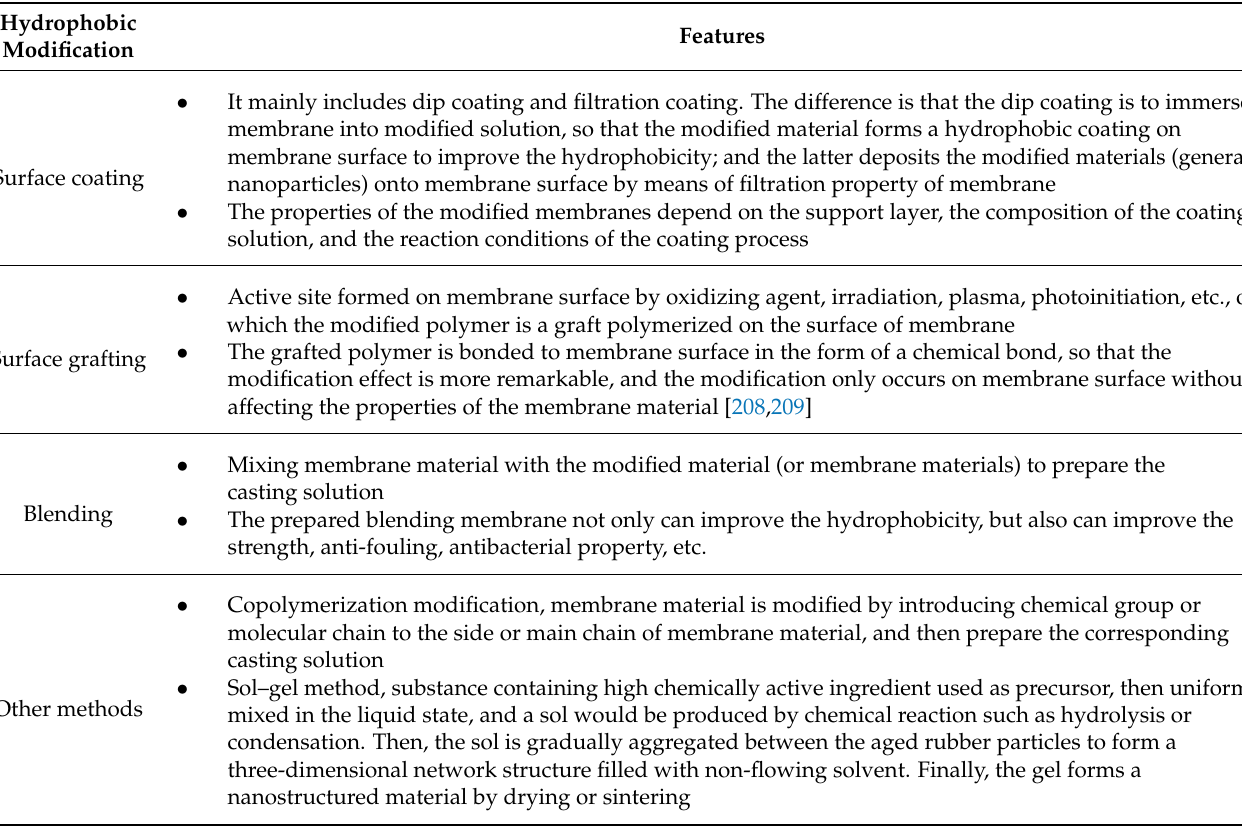
Table 5. Methods for hydrophobic modification on membranes for